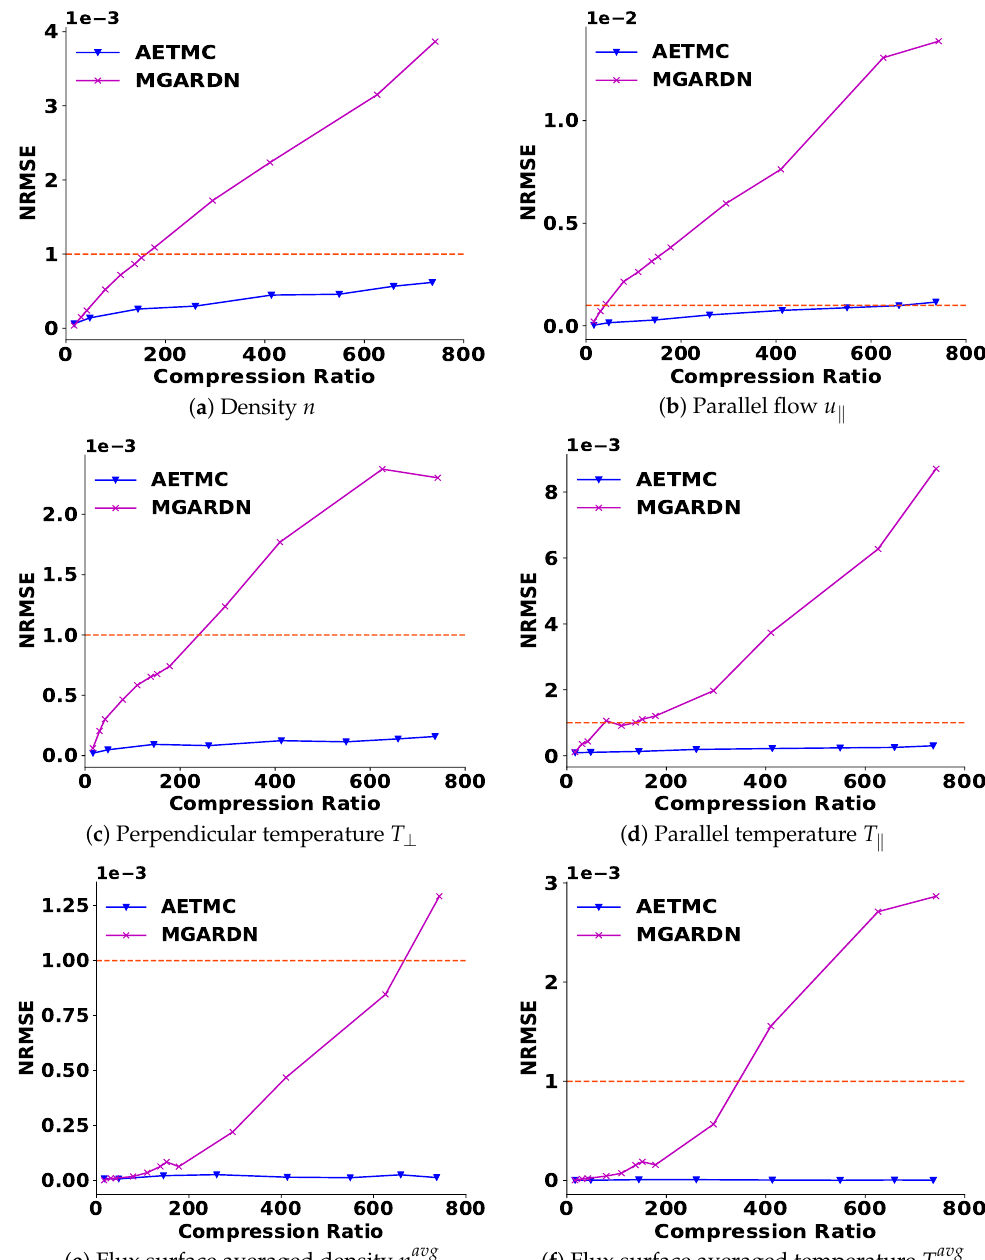
Figure 6. Comparison of individual QoI between AETMC and MGARD. The graphs show that QoI errors of AETMC remain almost constant as a result of constraint